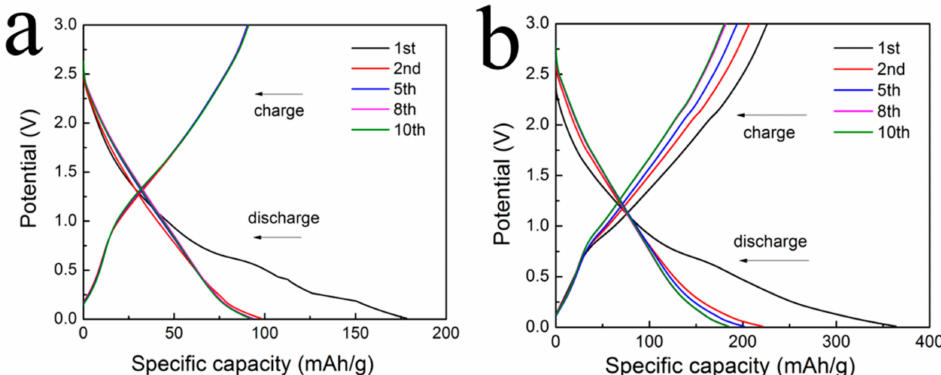
Figure 5. Charge–discharge profiles of ( a ) Ti 3 C 2 T x and ( b ) the RGO/Ti 3 C 2 T x nanocomposite electrode at different cycles with a current density of 50 mA/g.